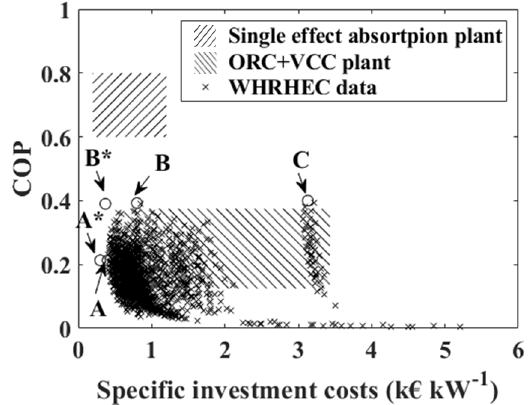
Figure 8. System performance and specific investment costs range of organic Rankine cycle (ORC) + vapor compression cycle (VCC) and single e ff ect absorption plant. Highlighted solutions: A (minimum cost), C (maximum performance), and B (best compromise between cost and COP). Asterisk solutions A * and B * refer to plate heat exchanger type at the low-pressure evaporator instead of a shell and tube heat